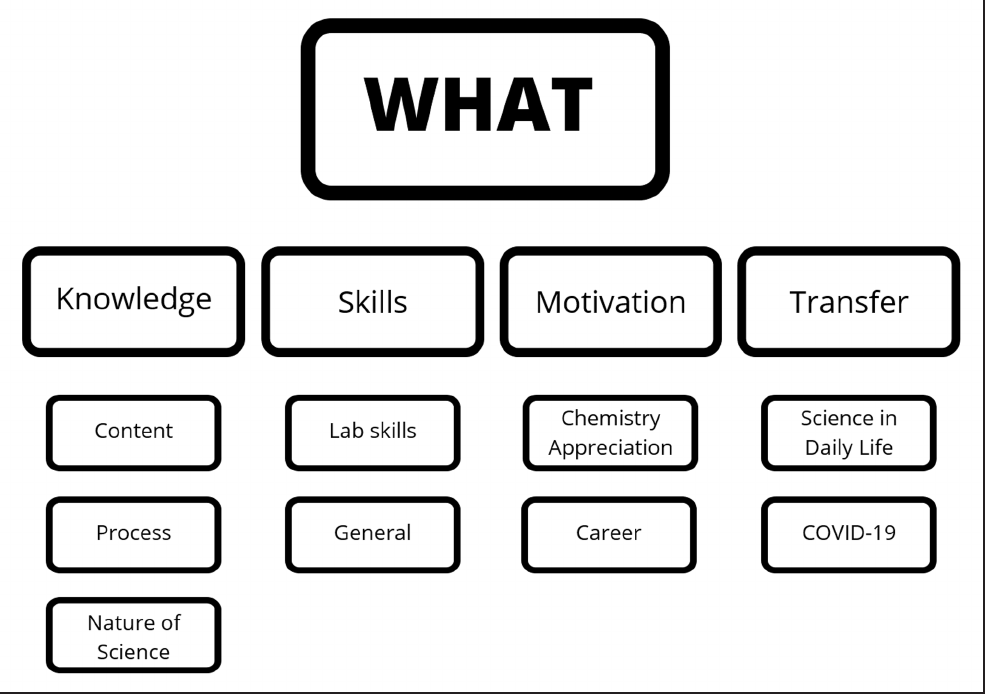
Figure 5 The diverse learning outcomes for